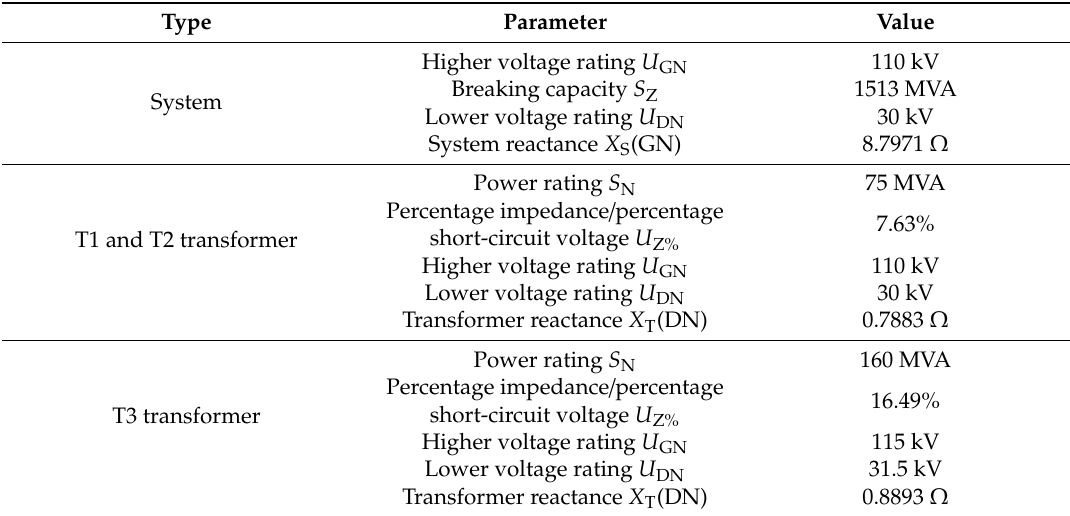
Table 1. Parameters of the transmission system and the transformer.